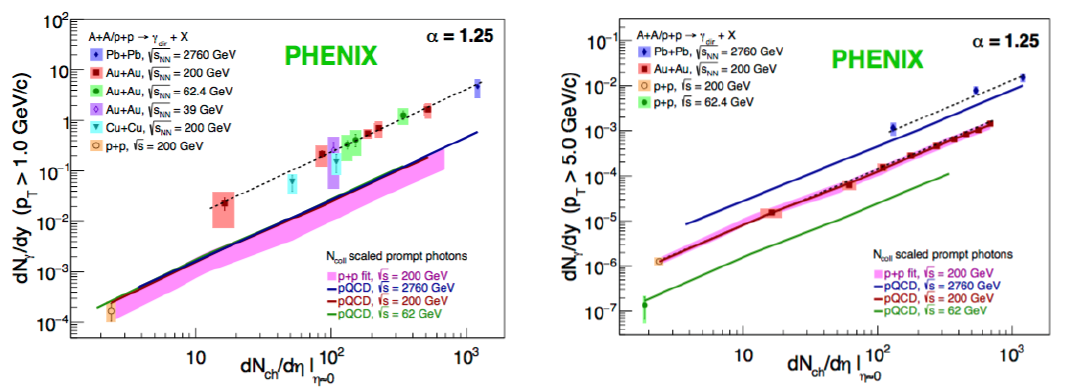
Figure 2. Integrated direct photon yield vs. dN ch / d η for different collision systems and energies, integrated in p T > 1 GeV/c ( left ) and p T > 5 GeV/c ( right ). The plots are from [3].